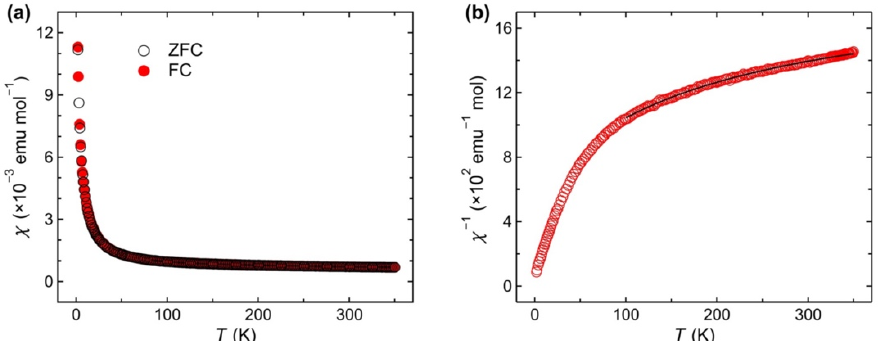
Figure 7. ( a ) Magnetic susceptibility as a function of temperature for S-2-2 collected at 0.1 T in field cooling (FC) and zero field cooling (ZFC) processes. ( b ) Curie fitting following Curie − Weiss law ( χ ( T ) = C /( T − θ ) + χ 0 ) in the temperature range 100 K < T < 350 K of FC data, yielding values of C = 7.2(2) × 10 − 2 emu/K mol, χ 0 = 5.20(4) × 10 − 4 emu/mol, θ w = − 65(4) K, where C , θ , and χ 0 stand for the Curie constant, Weiss temperature, and a constant.